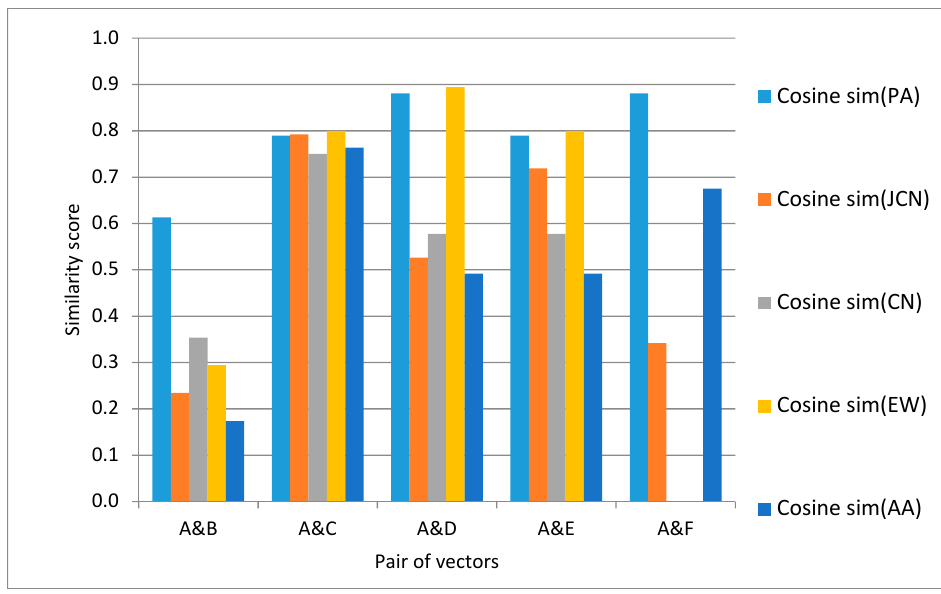
Figure 8. Similarity for neighbor based metrics. Table 3. Most similar node for node A.